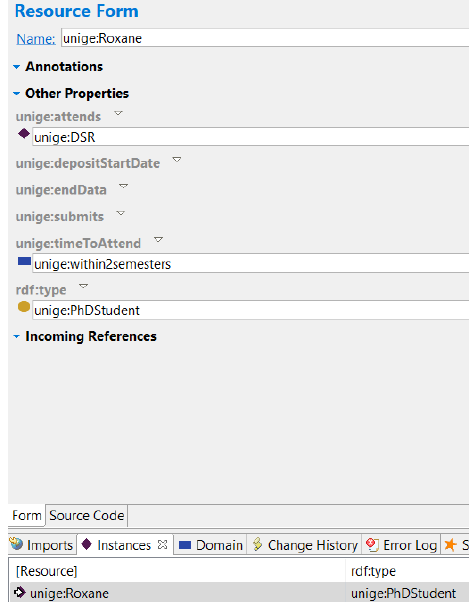
Rule Advanced scientific seminars : PhD student attends advanced scientific seminars for 5 days before the date of the thesis